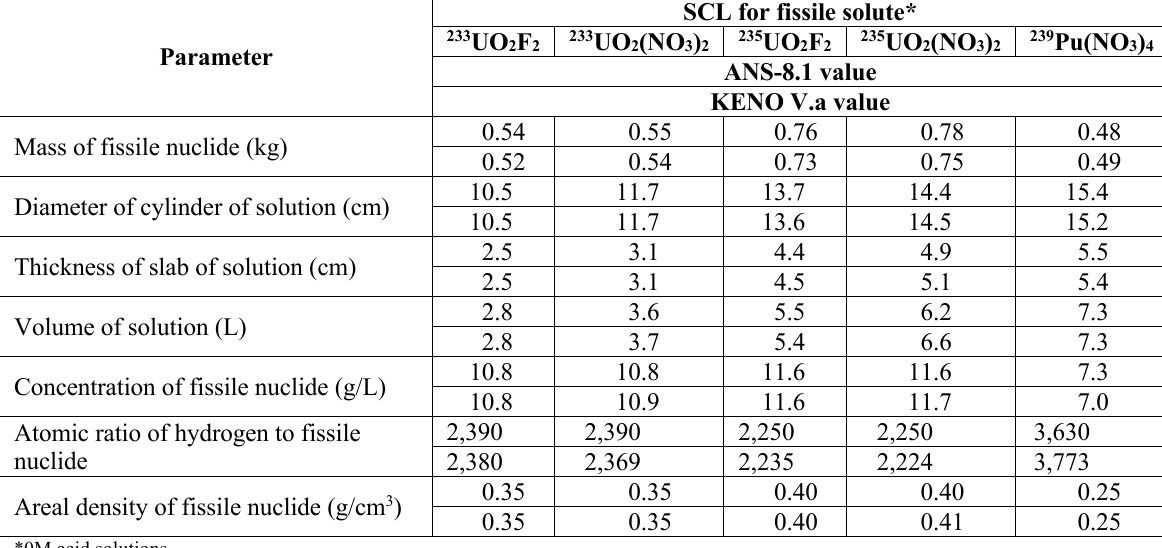
Table I. Single-parameter SCLs for uniform aqueous solutions of fissile nuclides.